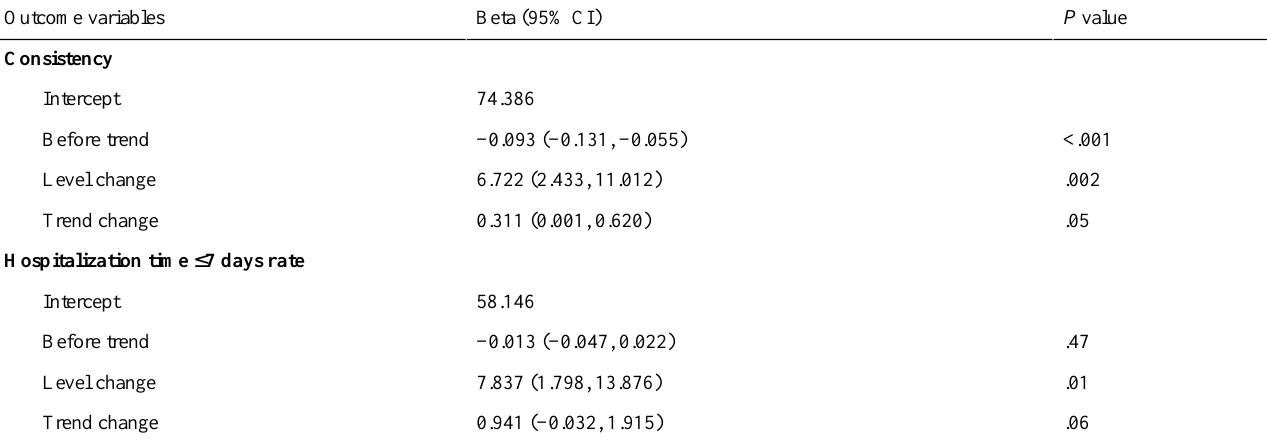
Table 5. Estimated levels and trend changes of the consistency rates and hospitalization times of 7 days or less before and after CDSS (clinical decision support systems)